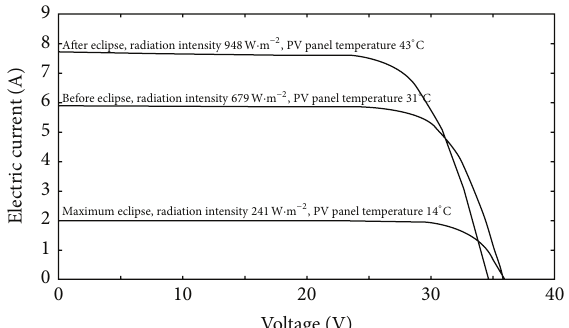
Figure 5: 𝐼 - 𝑉 characteristics of the Yingli 230 W p poly-Si PV panel in various stages of eclipse.